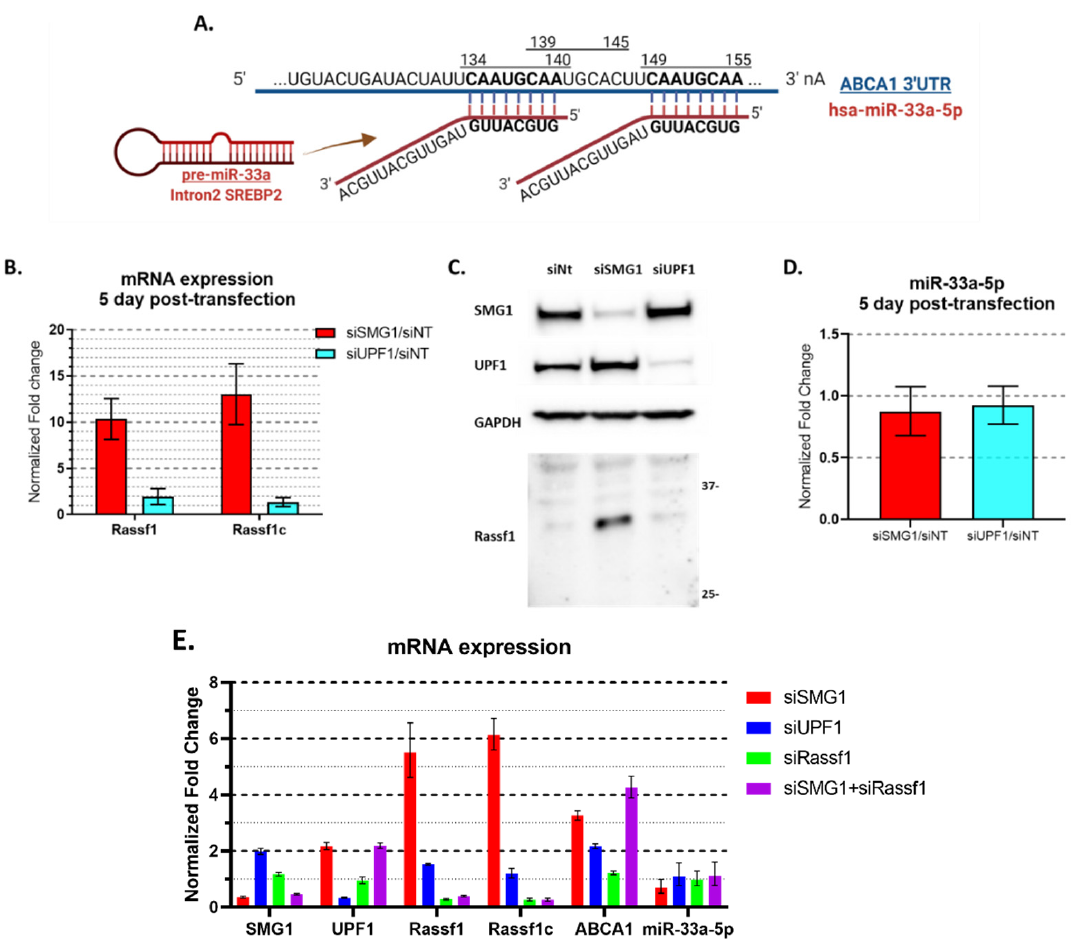
Figure 4. No effect of SMG1 inhibition on the expression of mir − 33a − 5p. ( A ) Schematic of miR − 33a − 5p and ABCA1 complementary sequences. miRNA − 33a − 5p, located in intron − 2 of the SREBP2 gene, is complementary to 3’ UTR of ABCA1 and inhibits ABCA1 expression [41–44]. Cre- ated with Biorender.com. ( B ) Summary RT-PCR results from three experiments (duplicated each) for RASSF1 and RASSF1C mRNA levels in MCF7 cells 5 days post transfection with siSMG1, siUPF1 or siNT. ( C ) Western blot results for RASSF1C (probed with Rassf1 [EPR7127], Abcam; see Appendix A Figure A4 for validation) on Western blots of a representative experiment showing MCF7 cells treated with different siRNAs. Cells are harvested 5 days post-transfection. ( D ) Summary RT-PCR for two experiments (duplicated each) for miR − 33a − 5p from RNA collected from MCF7 cells 5 days post transfection with siRNA targeting SMG1, UPF1 and non-target controls. miR − 33a − 5p cDNA were synthesized via TaqMan™ Advanced miRNA cDNA Synthesis Kit (Applied Biosystems), probed by TaqMan Advanced miRNA Assays and normalized by miR − 16 − 5p. ( E ) Representative RT-PCR mir − 33a − 5p results for a single triplicated experiment for MCF7 cells 3 days post-transfection with siSMG1, siUPF1, siRASSF1 or the combination of siSMG1 and siRASSF1. Error bars represent Mean ± SD. For all RT-PCR studies, individual samples are run in triplicate. Original Western blots, view Supplemental